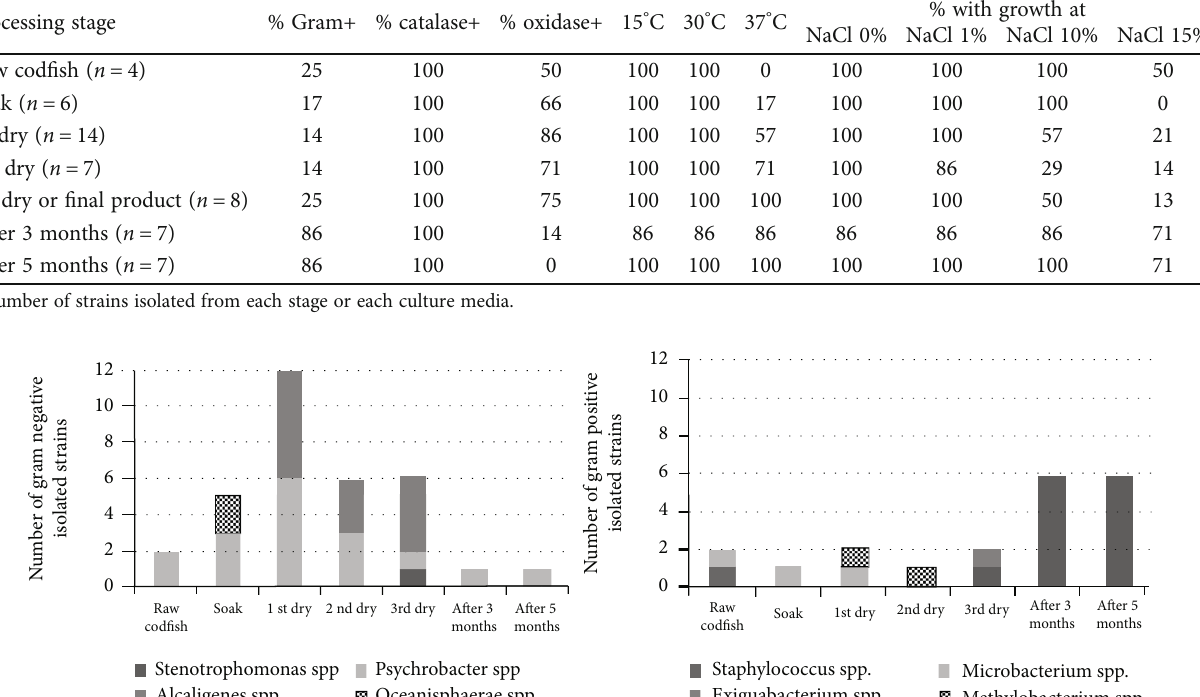
Table 1: Phenotypic characterization of microbial strains isolated according to the processing stage. Processing stage